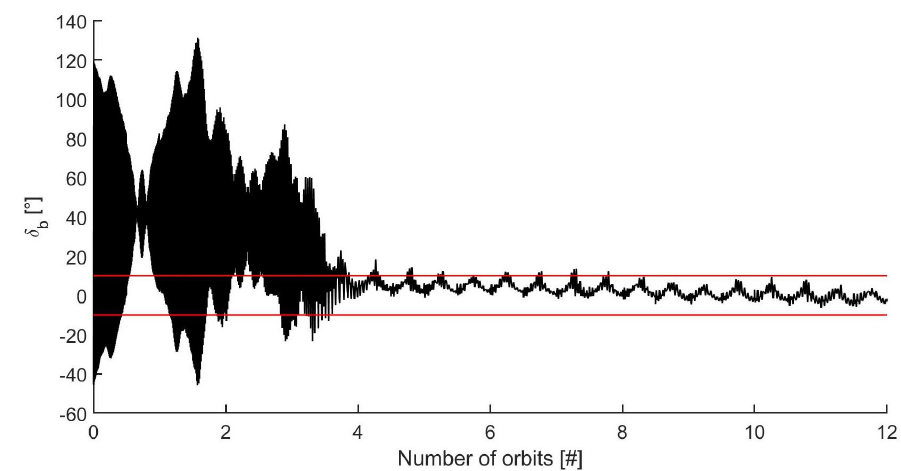
Figure 9. Misalignment error between ˆ z b and B b for PMACS with 2 permanent magnets.